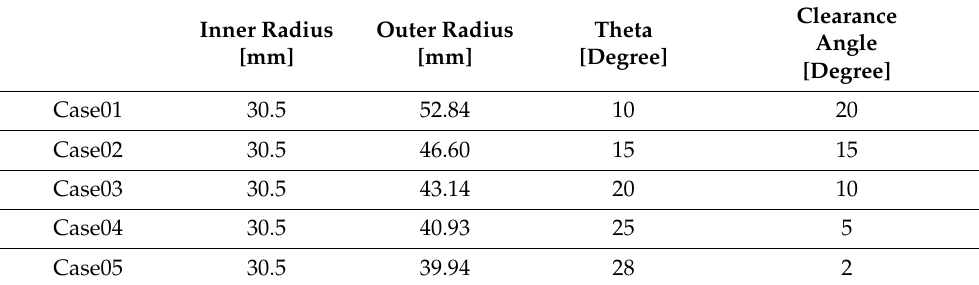
Figure 15. Design parameters for analyzing the effects of magnet arrangement clearance. Table 7. Model composition for verification of magnet arrangement